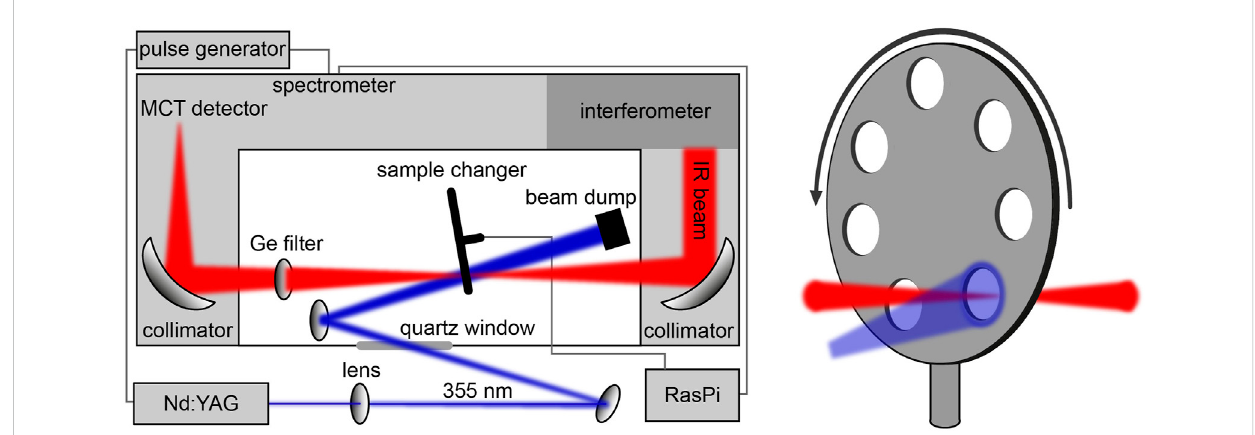
FIGURE 2 Schematic illustration of the setup for time-resolved rapid-scan FTIR difference experiments. A home-built sample changer controlled by an RaspberryPi (RasPi) was implemented in the spectrometer for the automated measurement of seven samples. TTL pulses from the spectrometer triggering the Nd:YAG laser were delayed by a pulse generator to synchronize the excitation with the onset of the data acquisition by the interferometer.